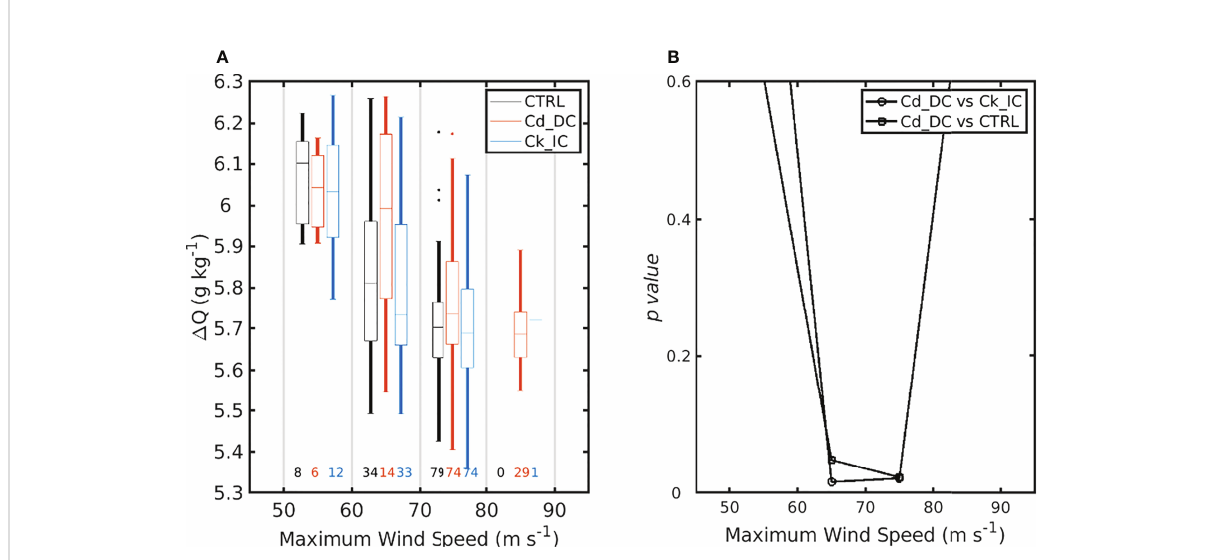
FIGURE 7 Same in Figure 6, but for (A) the air-sea moisture difference and (B) its p-values. The p in the p-values is